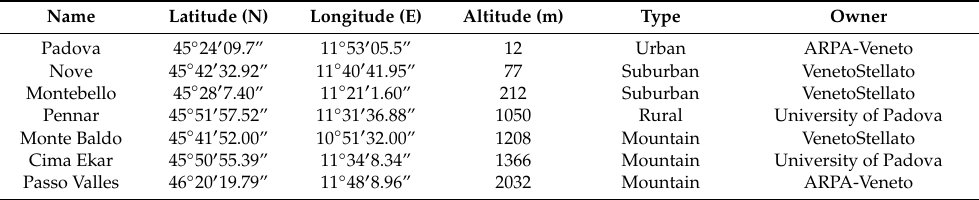
Table 1. Veneto’s Sky Quality Meter (SQM)